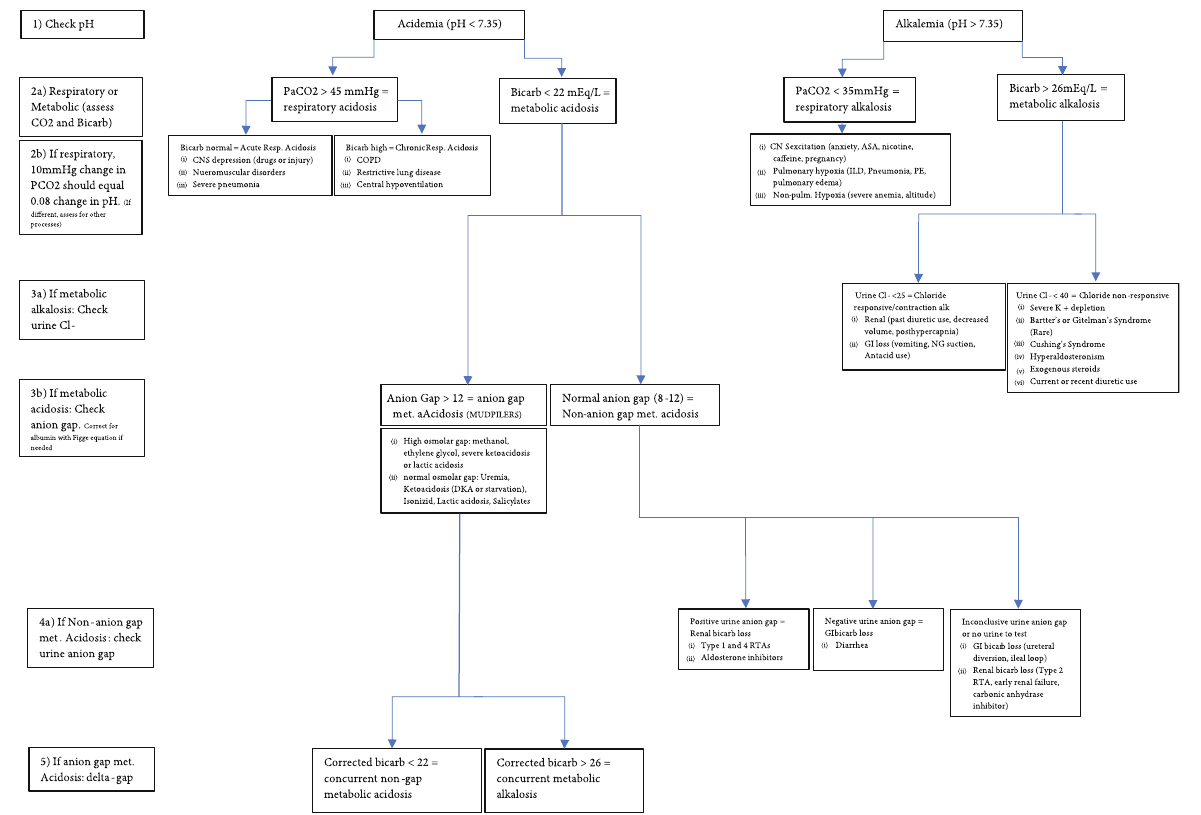
Figure 2: Comprehensive framework for acid-base